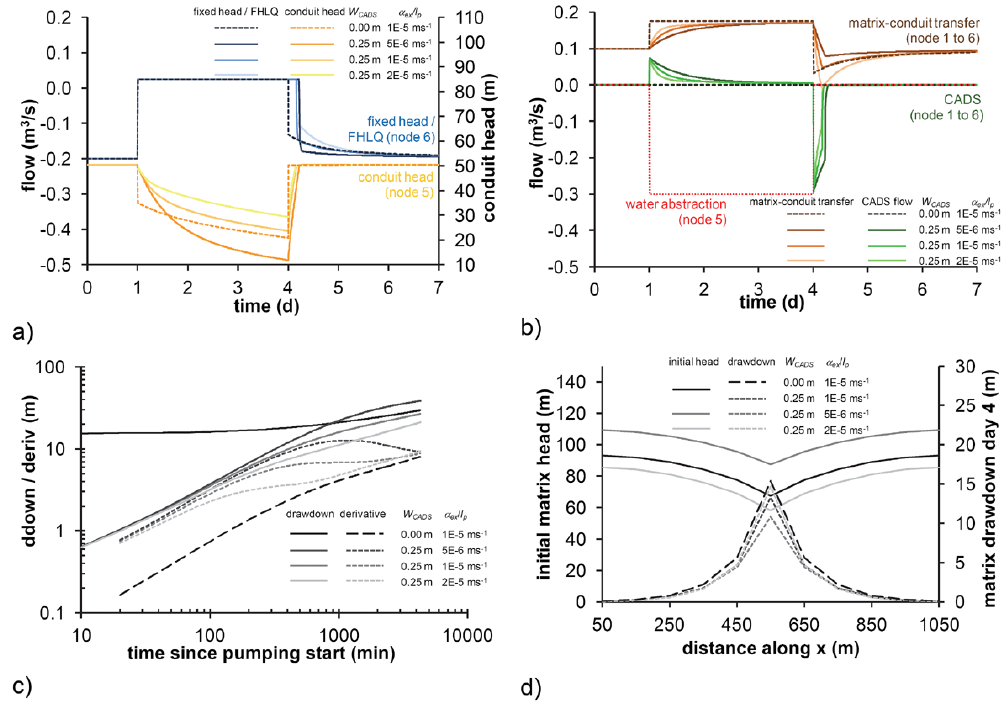
Fig. 8. Simulation results for the enhanced model (with CADS and FHLQ boundary condition): (a) flow terms for the fixed-head/FHLQ boundary and conduit heads at node 5; (b) flow terms for matrix transfer and CADS flow; (c) log-log diagnostic plot for conduit drawdown (solid lines) and drawdown derivative (dashed lines) at node 5; (d) initial matrix head and matrix drawdown at day 4 along the cross section A-A’ (Fig. 4).